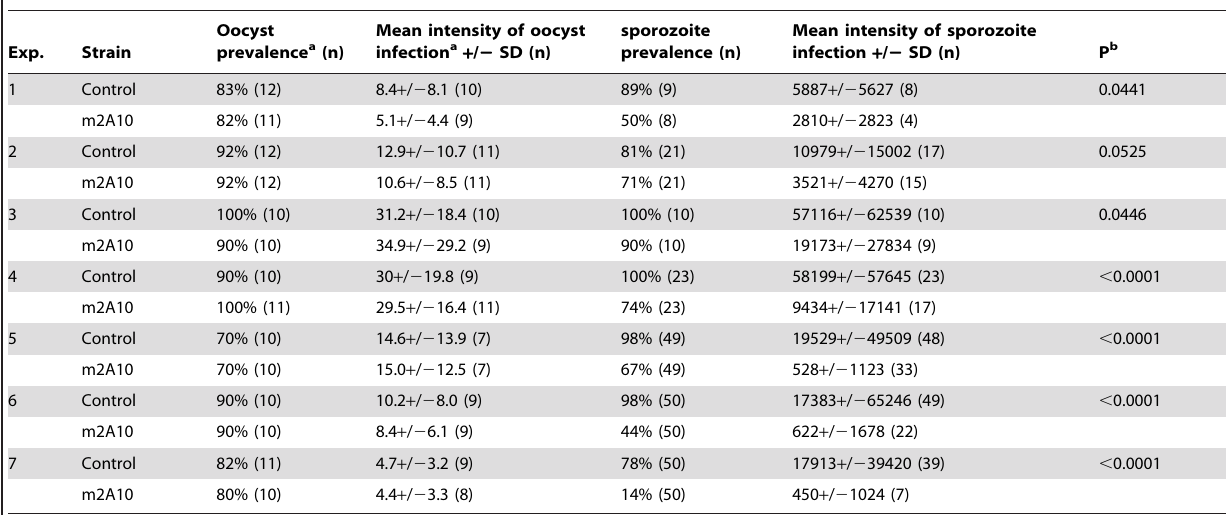
Table 2. Oocyst and sporozoite prevalence and mean intensity of infection in P. falciparum -infected mosquitoes.